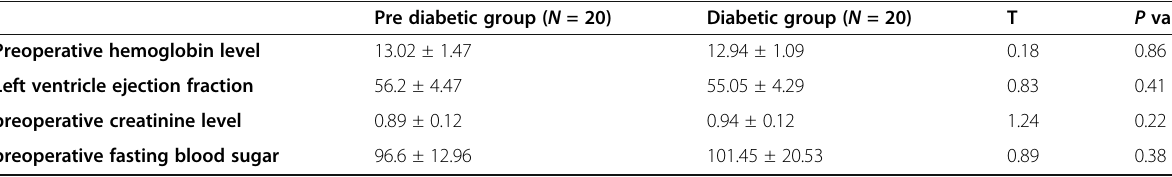
Table 2 Comparison between the two studied groups according to preoperative investigations Pre diabetic group ( N =